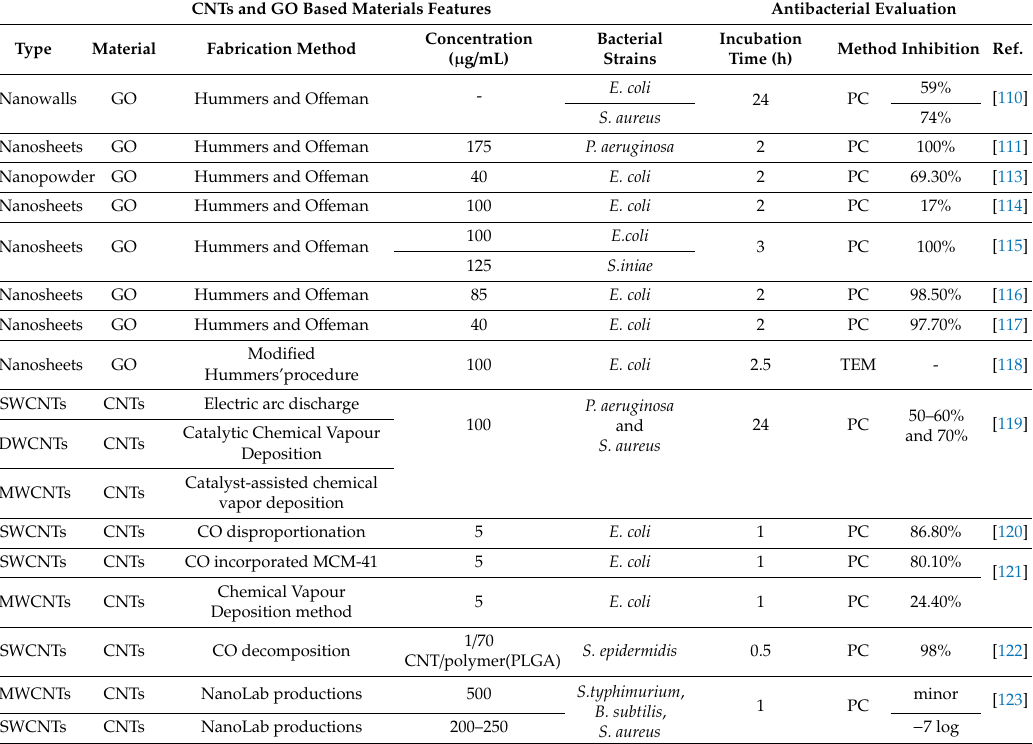
Figure 7. Schematic demonstration of the antibacterial activity of GO-based materials and killing activity of the GO towards bacteria [112]. Table 4. Characteristics and antibacterial behavior of CNTs and GO-based